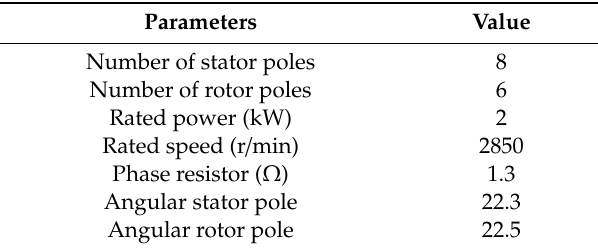
Table 3. Characteristics of the motor.